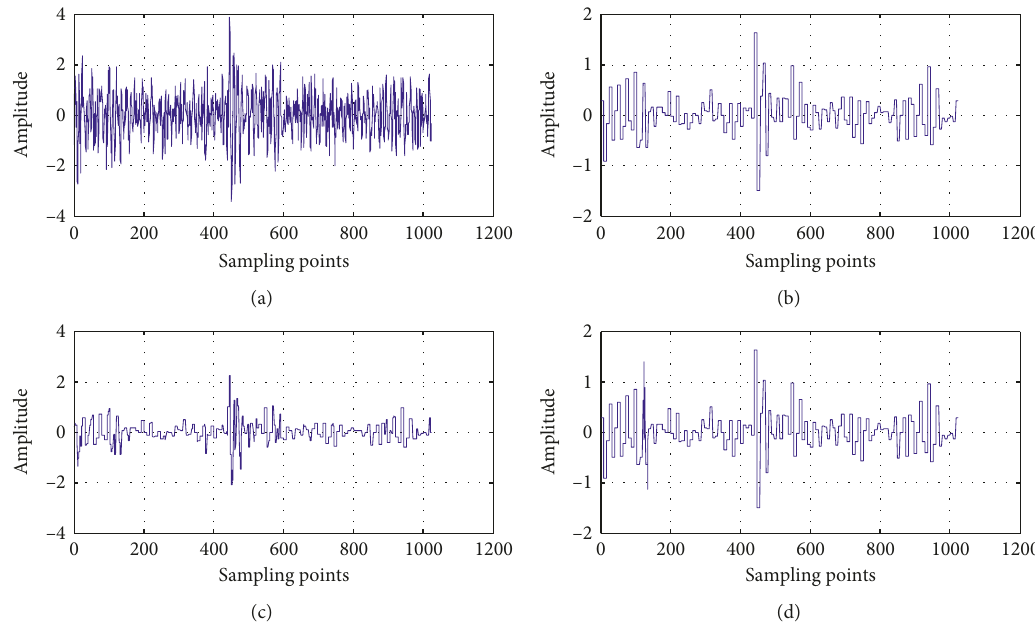
Figure 10: Inner wear signal and the waveform after denoising. (a) Inner wear signal. (b) Hard threshold denoised signal. (c) Default threshold denoised signal. (d) Given soft threshold denoised